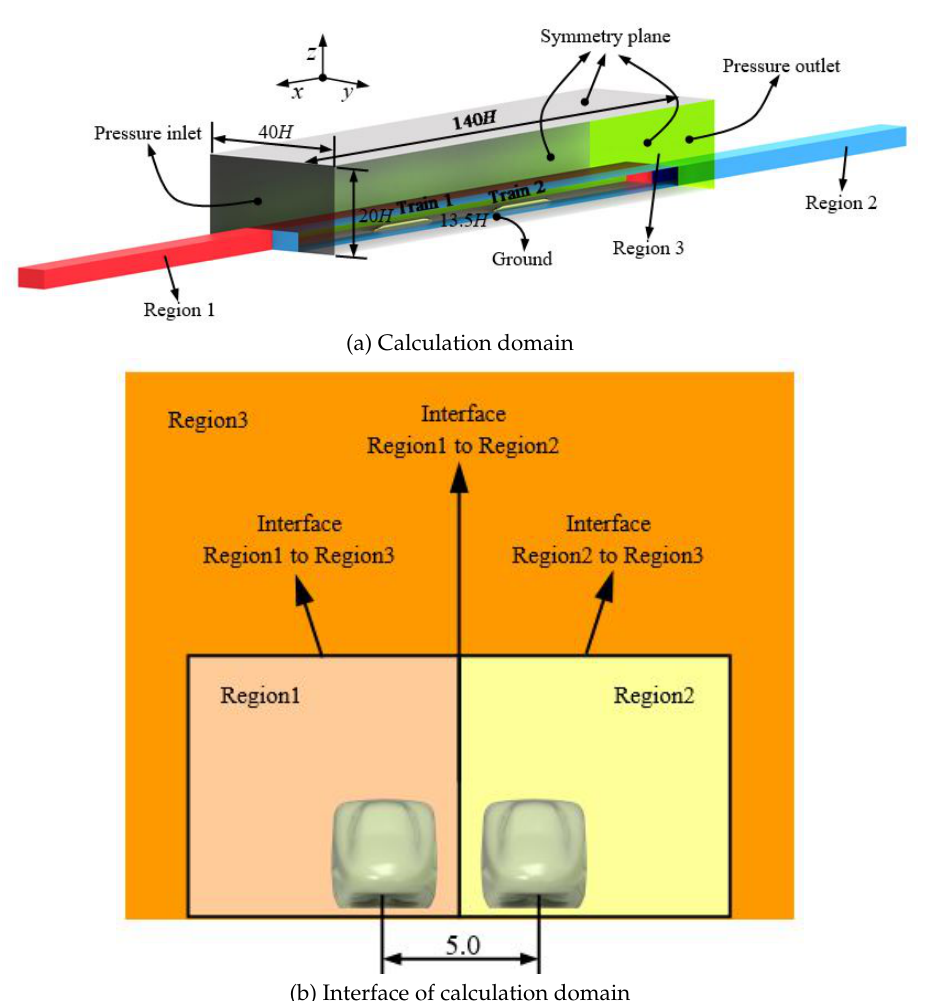
Fig. 4. Division of calculation domain (unit: m)